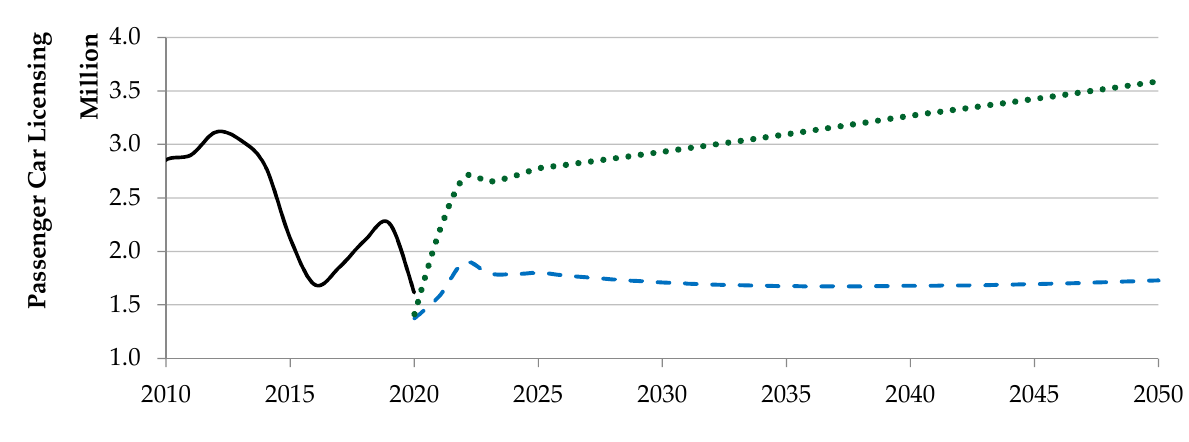
Figure 2. Projection of passenger car licensing in Brazil, 2021 to 2050.